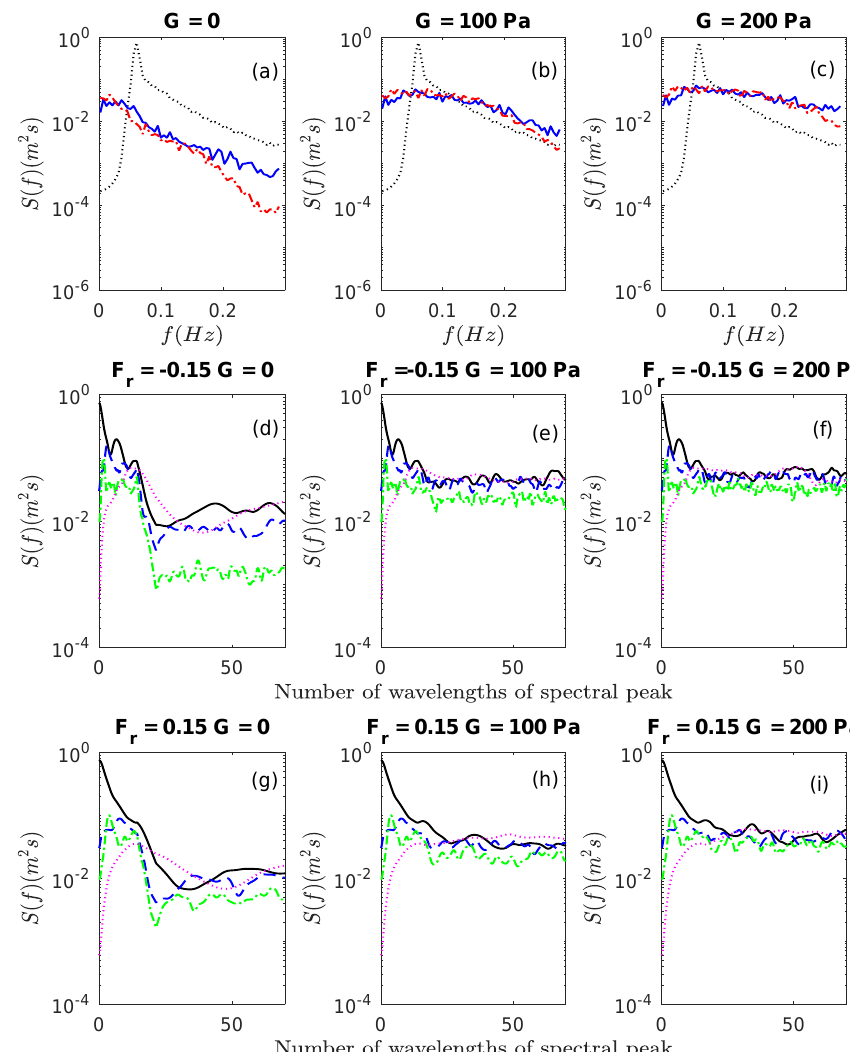
Figure 11. Evolution of random wave spectra with peak frequency of f p = 0.0625 Hz for two values of mud shear modulus of G = 0,100 and 200 Pa ( U r = 2.08, h = 2.00 m, d m = 0.20 m, and ρ m = 1111 kg/m 3 , and ζ = 100). In ( a – c ): dot-line is initial spectra at x = 0, solid-line is spectra at x = 21 L p for Fr = + 0.15, and dashed-line is spectra at x = 21 L p for Fr = − 0.15 ( L p is the wavelength of spectral peak). ( d – i ): energy density at spectral peak (dot-line), second (dashed line), and third (dashed-dot line) harmonic of the peak, and subharmonic of the peak ( f p /2) (solid